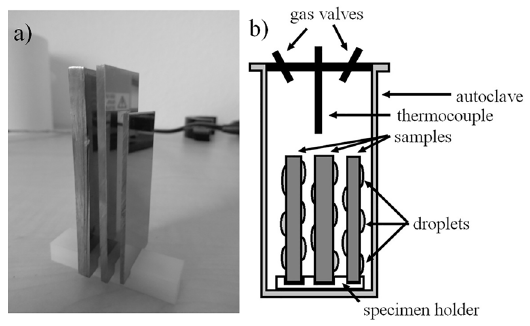
Figure 4. Samples fixed on the specimen holder (a) and a schematic illustration of the samples positioned inside the autoclave